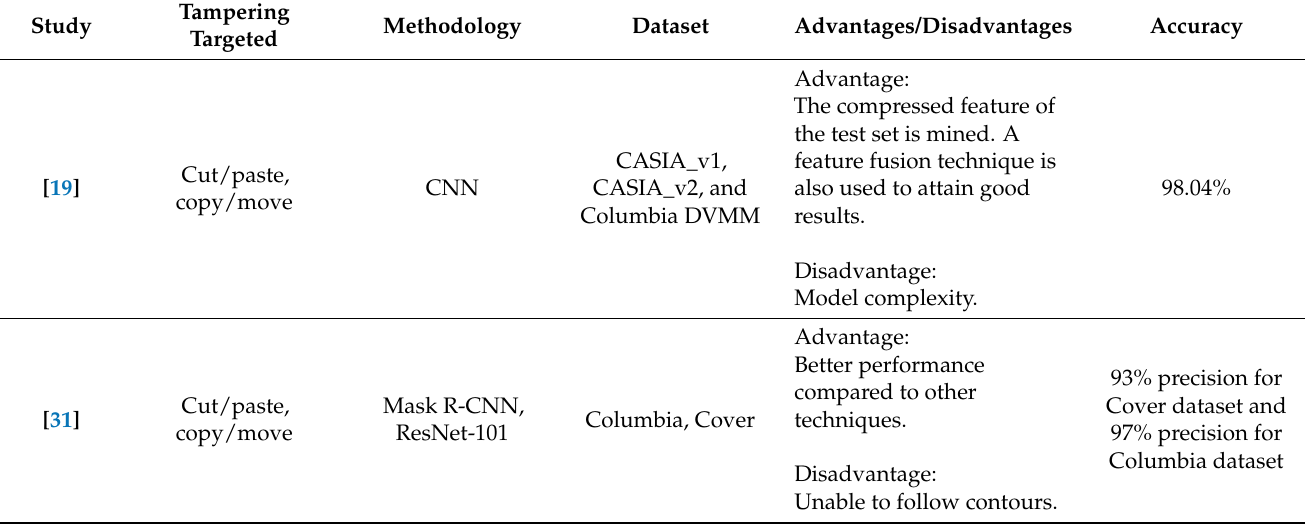
Table 5. Comparison between existing